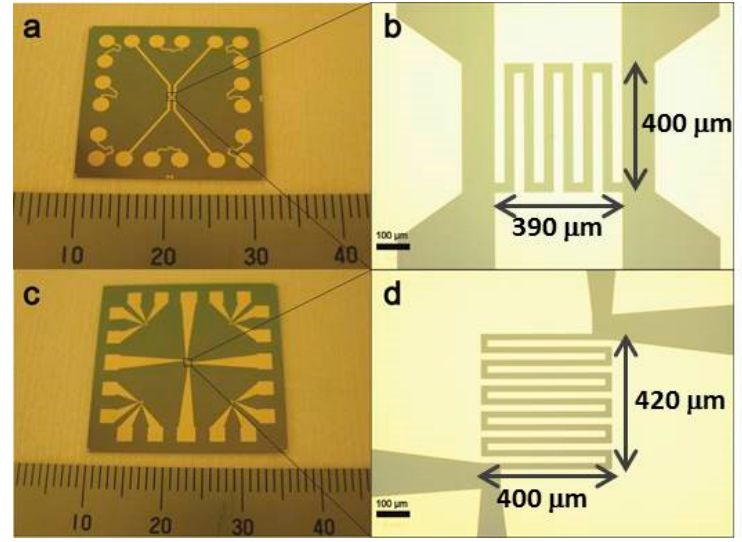
Figure 9. Redesigned resistance thermometers with larger area available for the heat spreader ( a , c ), and wider terminal wires ( b , d ).